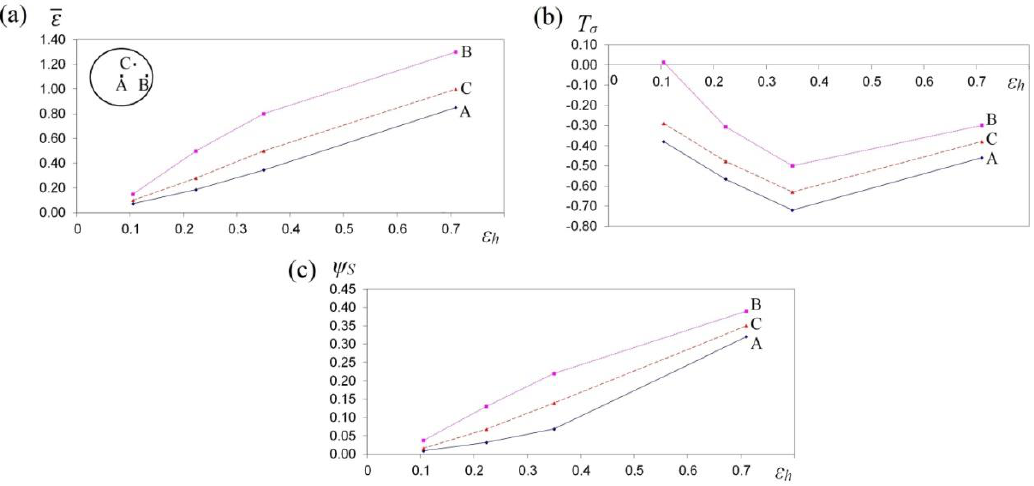
Figure 14. The variation in e ff ective strain ε ( a ), stress triaxiality T σ ( b ) and the deformation damage factor Ψ S ( c ) at selected points A, B and C during the cogging process of the X32CrMoV12-28 die steel specimens in the assembly of three-radial anvils.